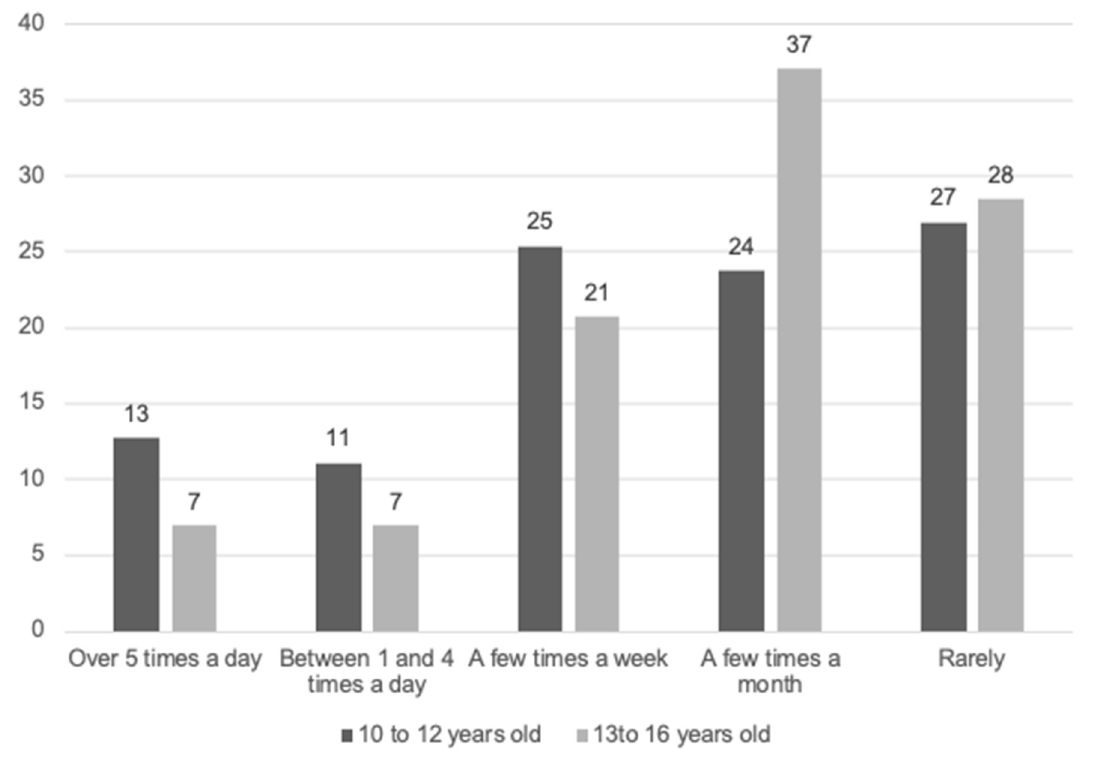
Figure 8. Frequency of content creation on TikTok (in percentage).